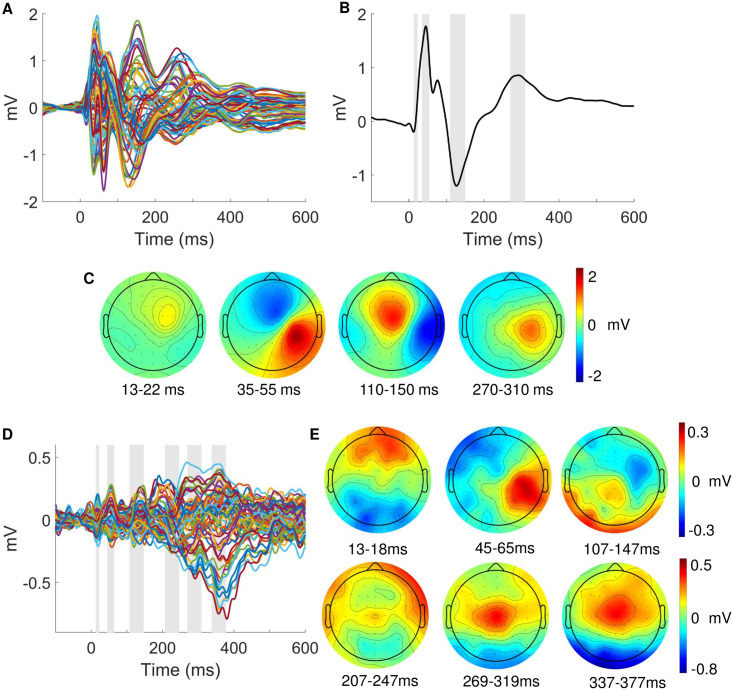
Event-related potentials.(A) Grand average SEP of all 64 electrodes. (B) Average SEP across electrodes C4, C6, CP4, CP6 (contralateral to stimulation). Grey bars indicate time windows around the standard somatosensory ERP components (13-23ms; 35-55ms; 110-150ms; 270-310ms). (C) ERP scalp topographies corresponding to the time windows in B. (D) Grand average ERP of the mismatch response obtained by subtraction of standard from deviant trials of 64 electrodes. Grey bars indicate windows around peaks which were identified within pre-specified time windows of interest around somatosensory ERP or expected mismatch response components (13-18ms; 45-65ms; 107-147ms; 207-247ms 269-319ms; 337-377ms). (E) ERP scalp topographies corresponding to the time windows in D).